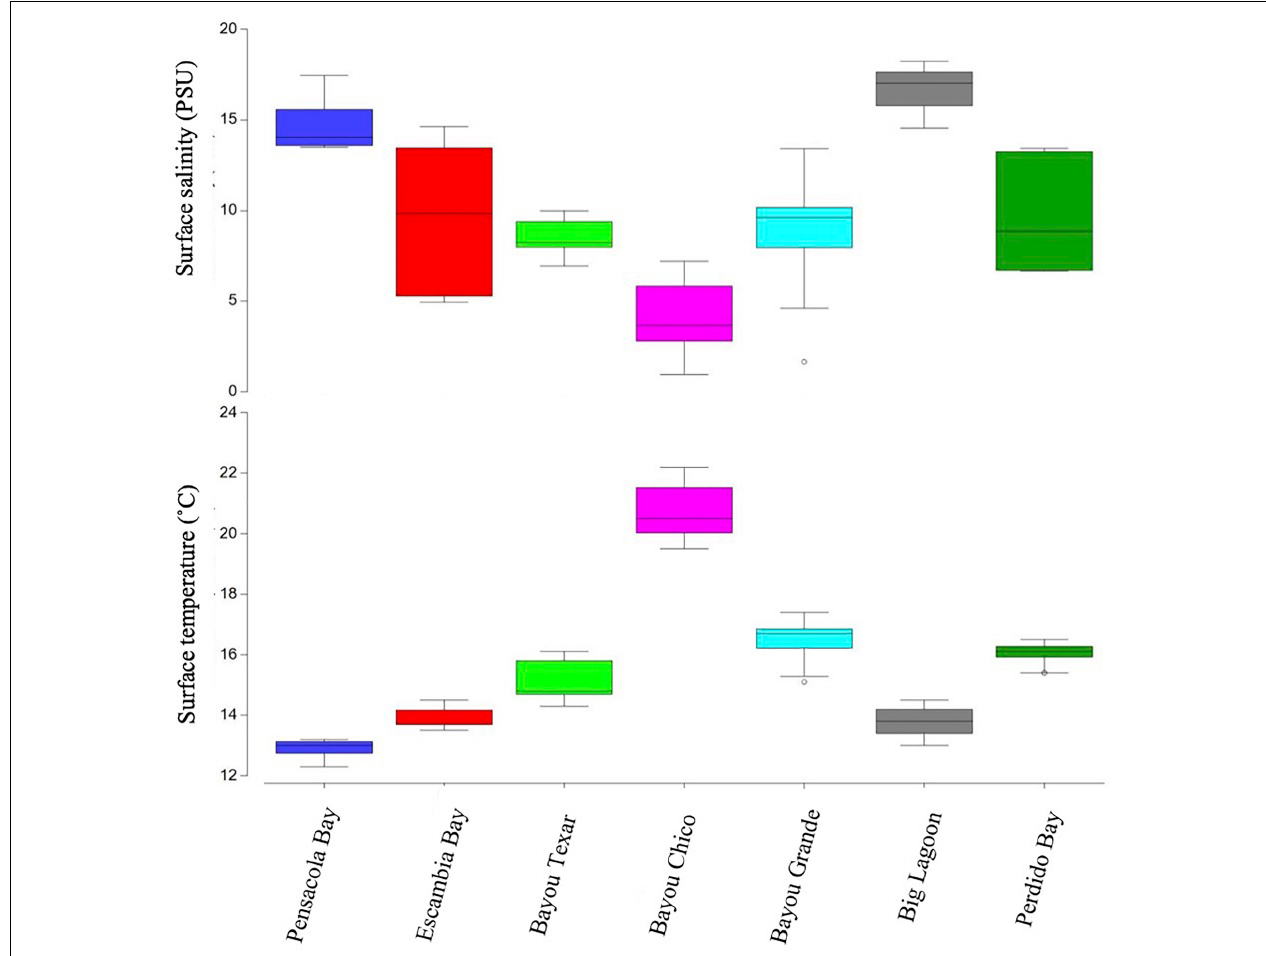
FIGURE 1 | Boxplots of surface water salinity and temperature. Open circles denote extreme values; box-tops and -bottoms show the 25th and 75th percentiles; lines within boxes mark mean values; and whiskers indicate minimums and